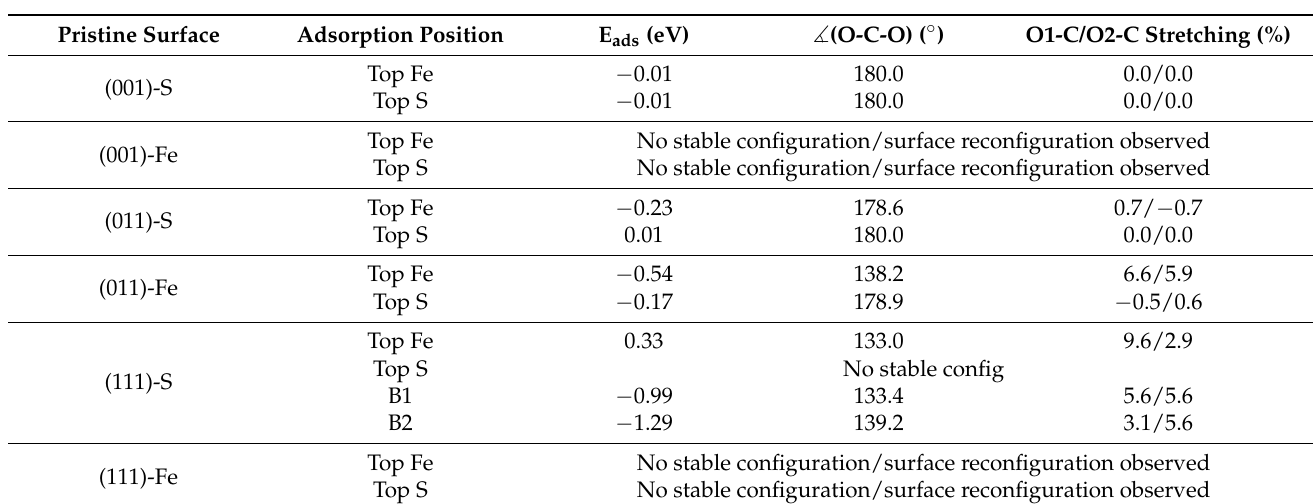
Table 2. Calculated adsorption energy (E ads ), CO 2 inner angle ( (cid:93) (O-C-O)), and O-C bond stretching (O1-C/O2-C) of a single CO 2 molecule adsorbed on three pristine low Miller index surfaces of FeS mackinawite. The B1 and B2 adsorption position nomenclature were taken from the work of Dzade et al. [24].